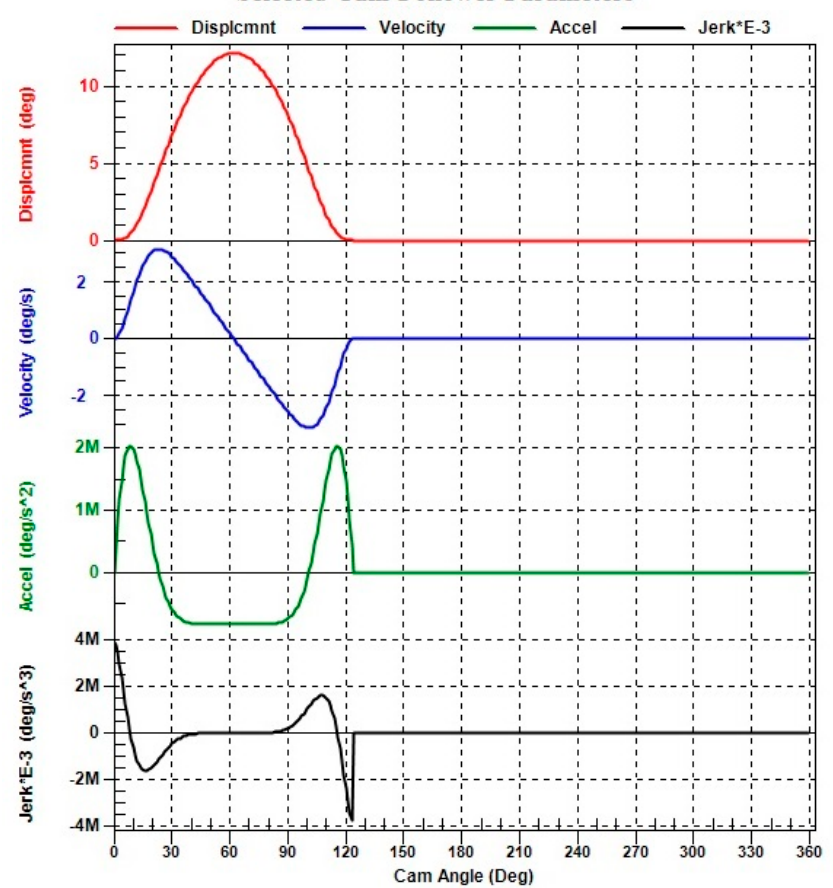
Figure 5. Kinematic graphics that have been obtained with Dynacam.